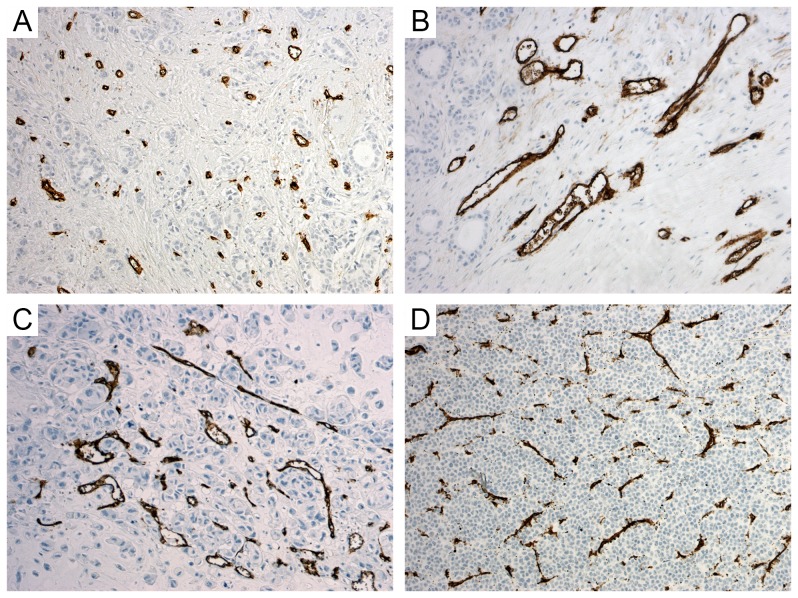
CD34 section case examples.A) High MVSμ; low MVPμ, MVAΣ and MVD; B) Average MVSμ, high MVPμ and MVAΣ, and low MVD; C) Low MVSμ, high MVPμ and MVAΣ, and low MVD; D) Low MVSμ, average MVPμ and MVAΣ, and high MVD. High MVPμ values (large vessels) and low MVSμ values (high complexity shapes) contribute to poor prognosis; as well as high MVAΣ values (high vascular area) [29], but MVD is inconsequential [29].